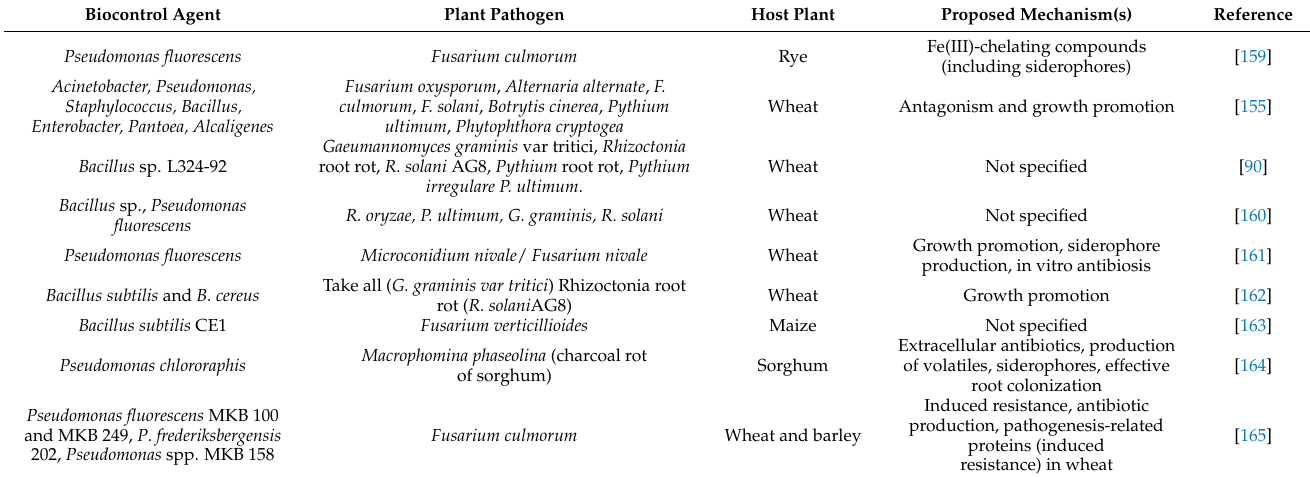
Table 2. Summary of studies on rhizobacterial mechanisms involved in